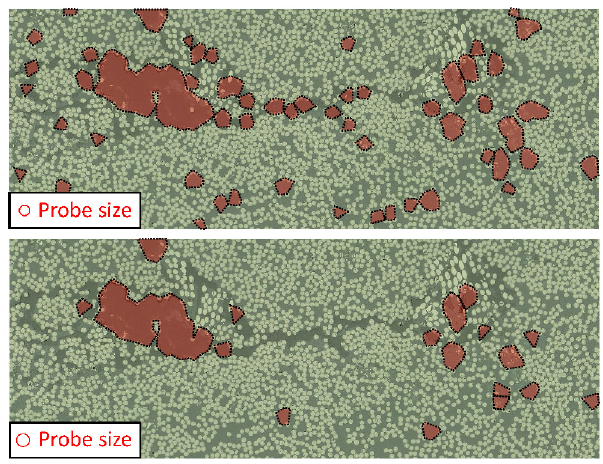
Fig. 25 Effect of changing α . Above: 55 detected fiber-deficient areas when α = 2 R mode . Below: 18 detected areas when α = 2 . 5 R mode